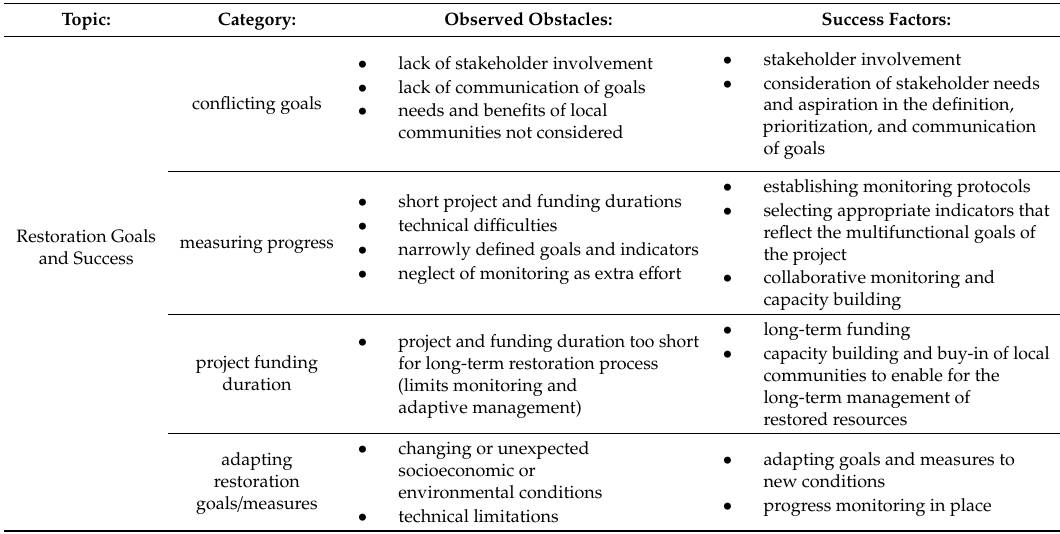
Table 5. Overview of the topics presented in this publication, with the di ff erent categories to which the obstacles and problems of restoration, as well as success factors, that were reported by the survey participants correspond. ANR: assisted natural